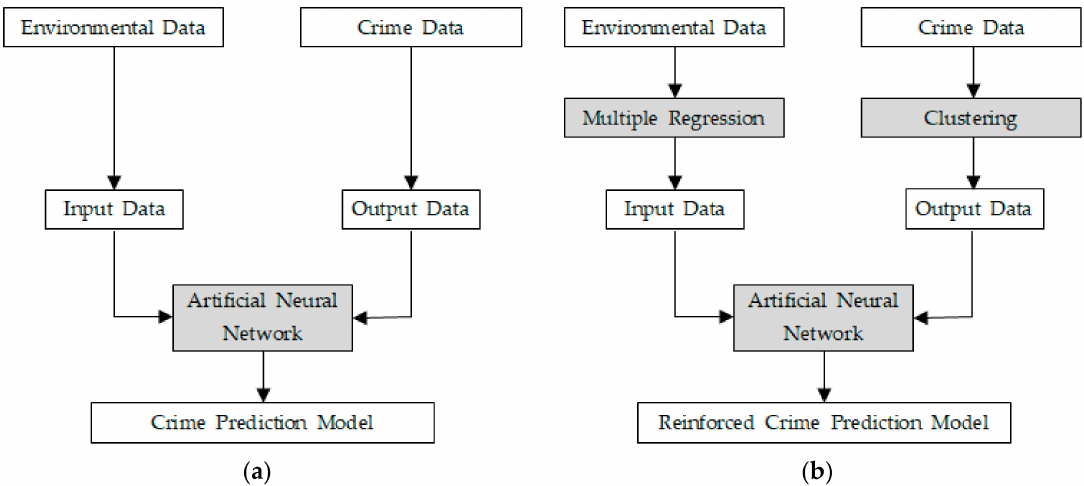
Figure 1. Differences in the development process of the ANN crime prediction model; ( a ) The development process of the general crime prediction model; ( b ) The development process of the crime prediction model proposed in this study.